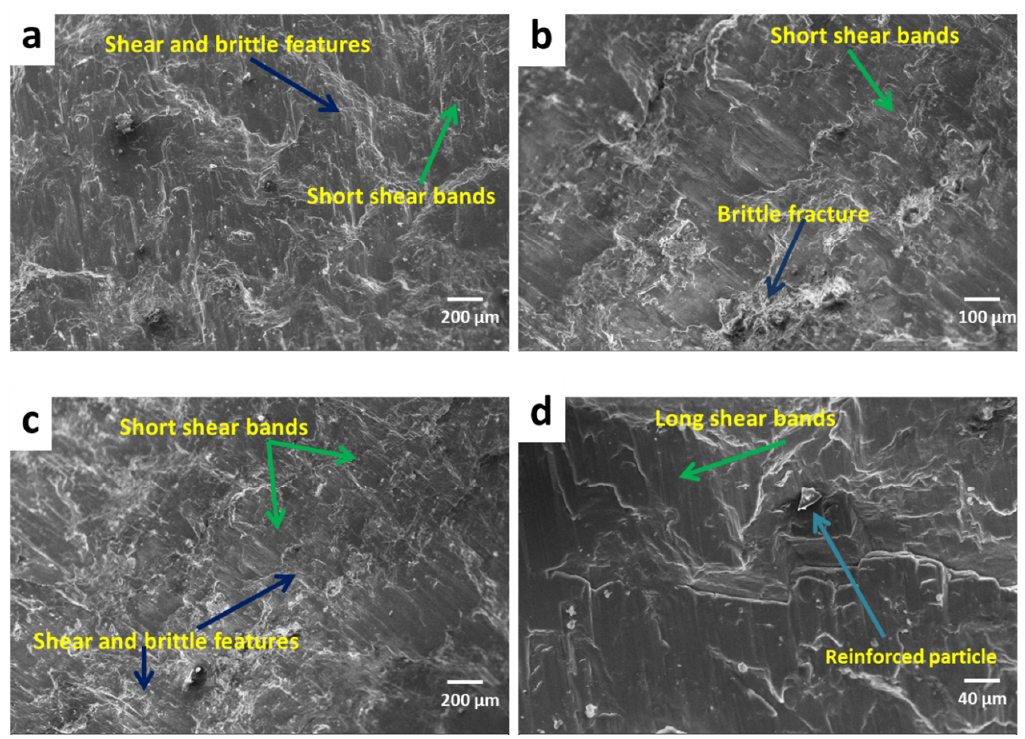
Figure 12. SEM compressive fractograph of AZ91-based composites reinforced with ( a ) 2% SiC, ( b ) 5% SiC, ( c ) 8% SiC, ( d ) 11% SiC.